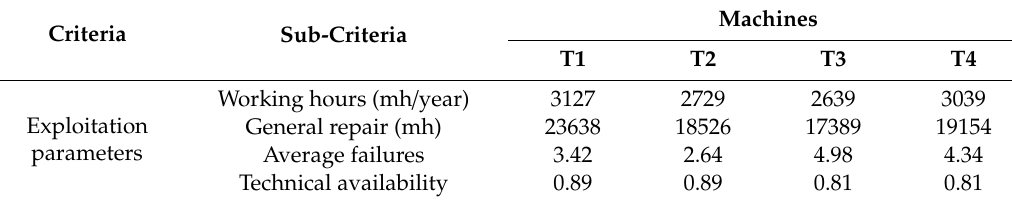
Table 10. Input parameters for applying the AHP method for exploitation parameters.